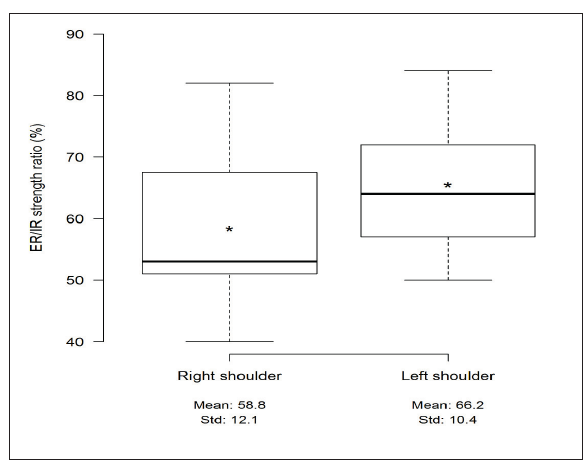
Figure 3 - Comparison between right and left shoulder ER/IR strength ratio in swimmers (*p < 0.05).